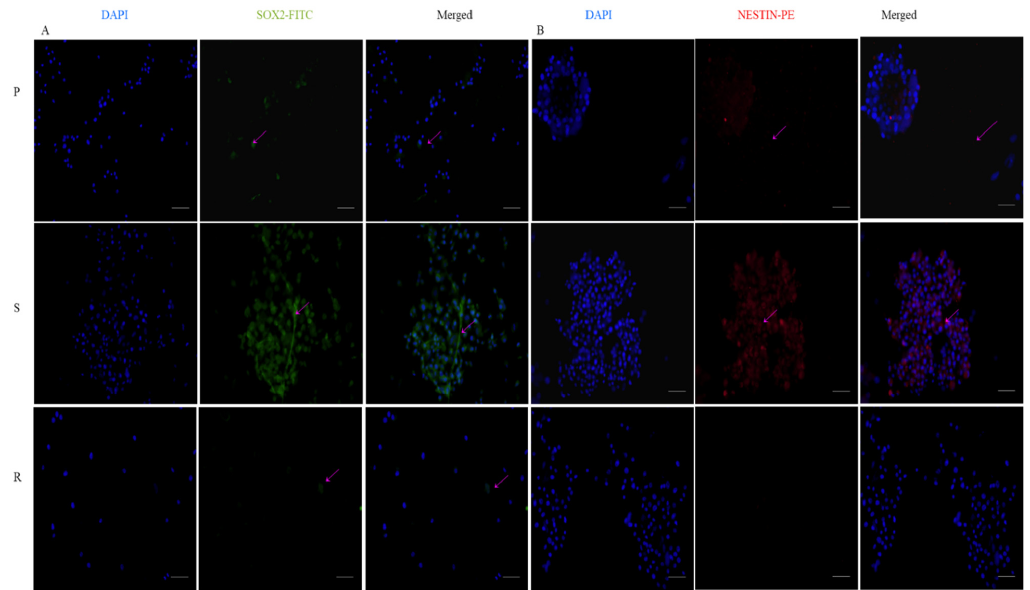
Figure 9. Expression of stemness markers: immunocytochemistry images of ( A ) Sox2 primary antibody stained with FITC and counterstained with DAPI; ( B ) Nestin-primary antibody stained with PE and counterstained with DAPI. The scale bar indicates 20 µ m.